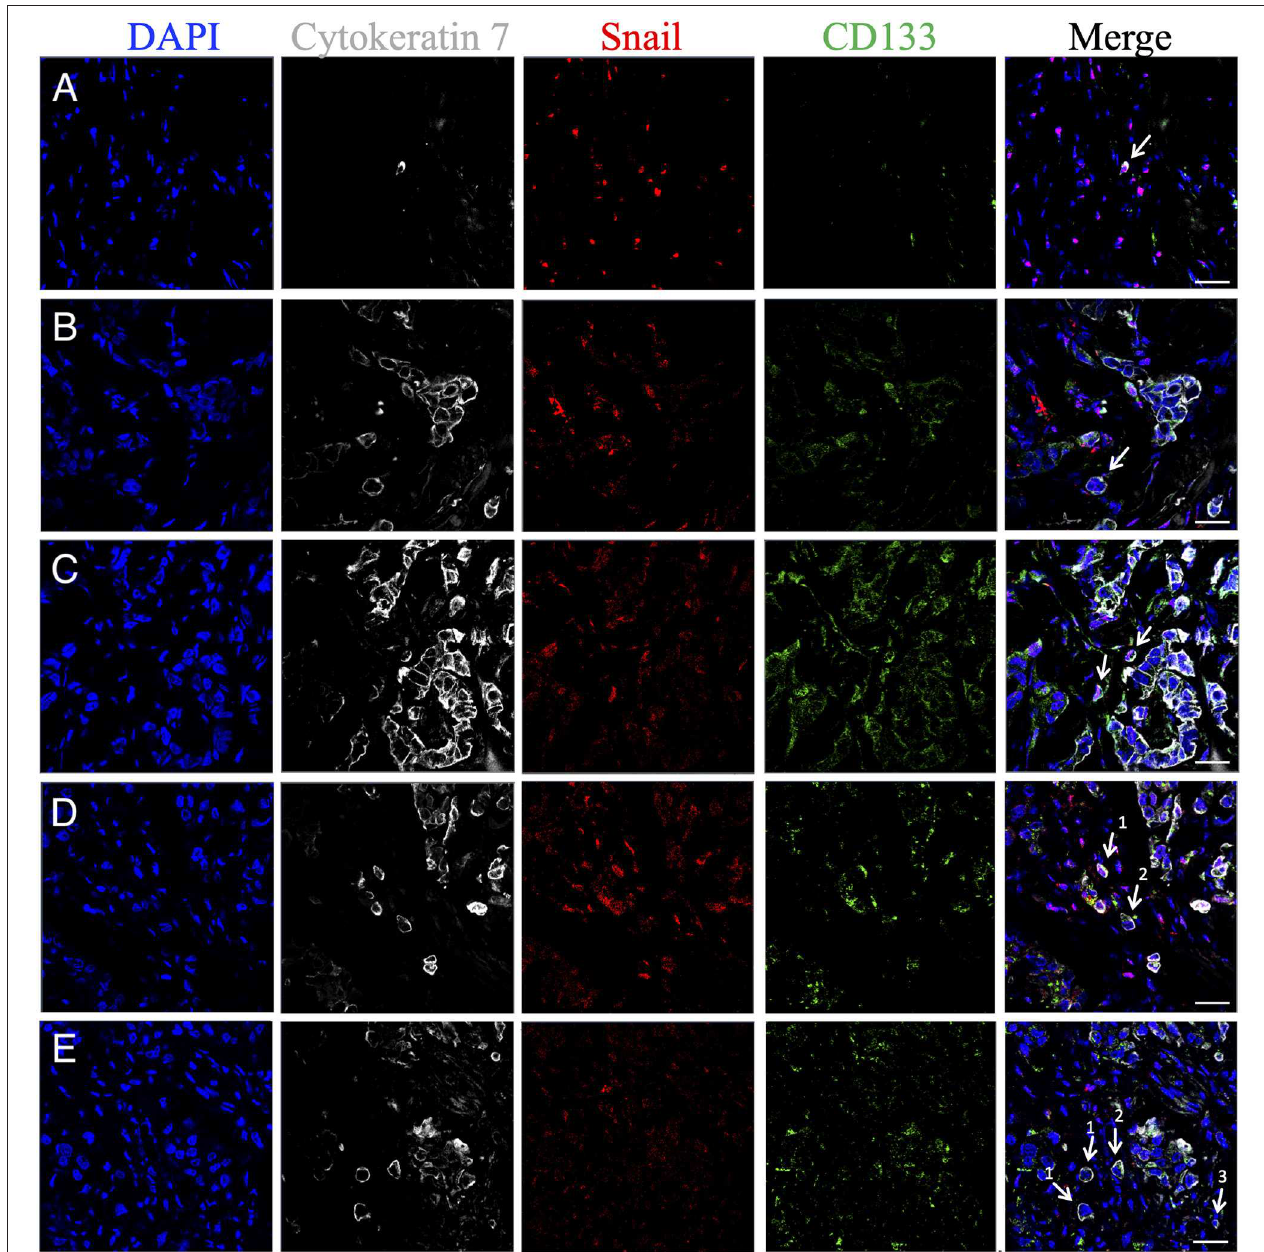
FIGURE 5 | Phenotypic heterogeneity of eSTCs and mSTCs in stem and early EMT features. (A) Nonstem mSTC with early EMT (CK7 + CD133 − Snail + ) surrounded by immune and stromal cells. (B) eSTC without stem and EMT features (CK7 + CD133 − Snail − ) near the multicellular structure. (C) Stem mSTC with early EMT (CK7 + CD133 + Snail + ) near the multicellular structure. (D) Stem mSTC with early EMT (CK7 + CD133 + Snail + ) among microenvironment cells (1) and stem eSTC without EMT (CK7 + CD133 + Snail − ) similar in size to tumor cells composing multicellular structures (2). (E) Nonstem eSTC without EMT (CK7 + CD133 − Snail − ) (1), stem eSTC without EMT (CK7 + CD133 + Snail − ) (2), and nonstem mSTC without EMT (CK7 + CD133 − Snail − ) among microenvironment cells. eSTCs were identified based on their similarity in size to tumor cells of multicellular structures, whereas mSTCs, to immune/stromal cells. Scale bar, 50 µ m.